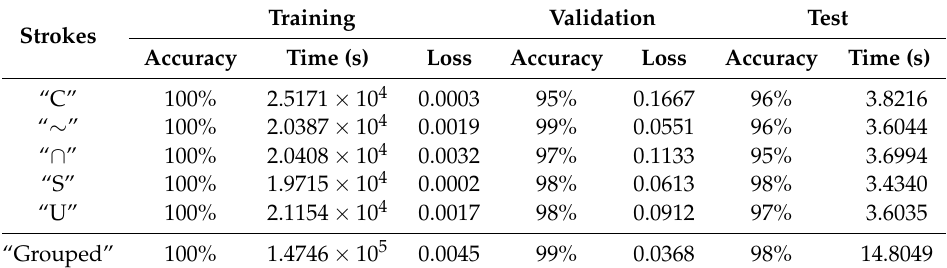
Table 10. Original Simple Grapheme - VGG-19 (epoch =